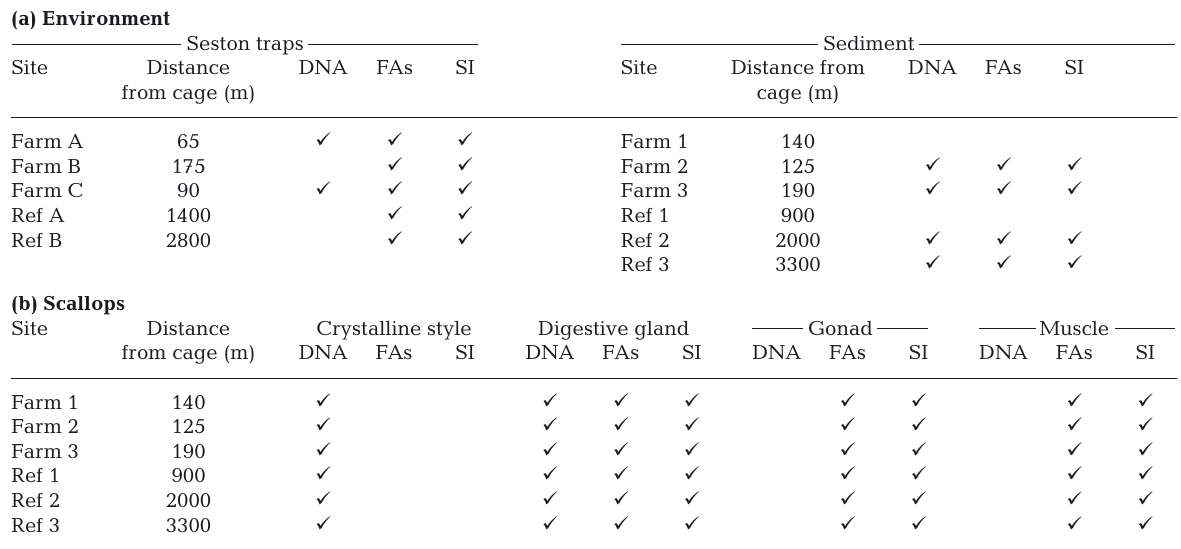
Table 1. Summary of sample collection sites and analyses performed. (a) Environmental samples and (b) king scallops Pecten maximus . All samples were collected in 2014. Refer to Fig. 1 for overview of area and site location in relation to